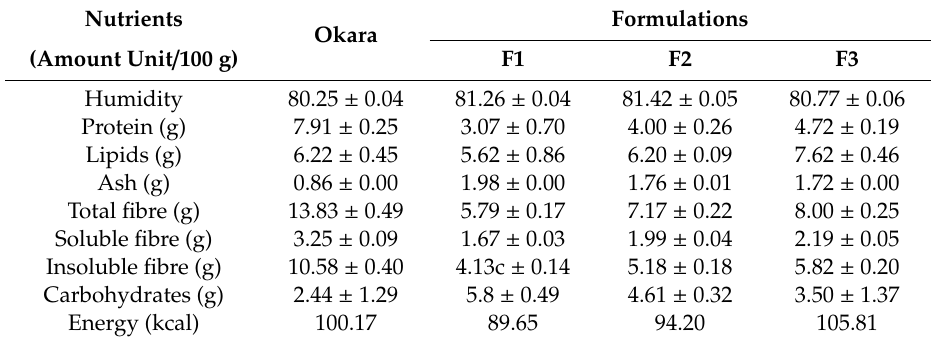
Table 6. Comparison of the chemical composition of okara and okara-based paste (100 g portion). Nutrients